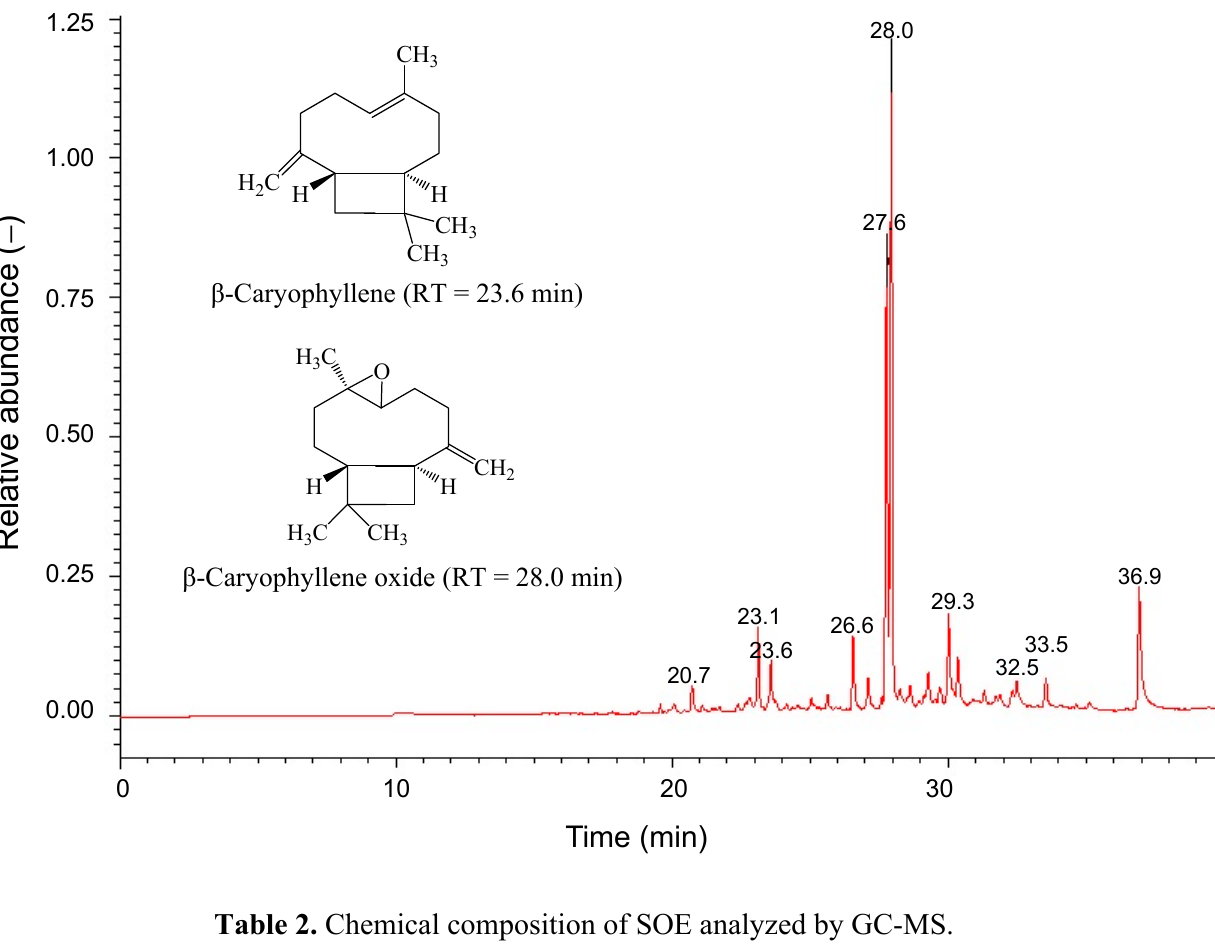
Figure 5. Gas chromatography-mass spectrometry profile of SOE sample.